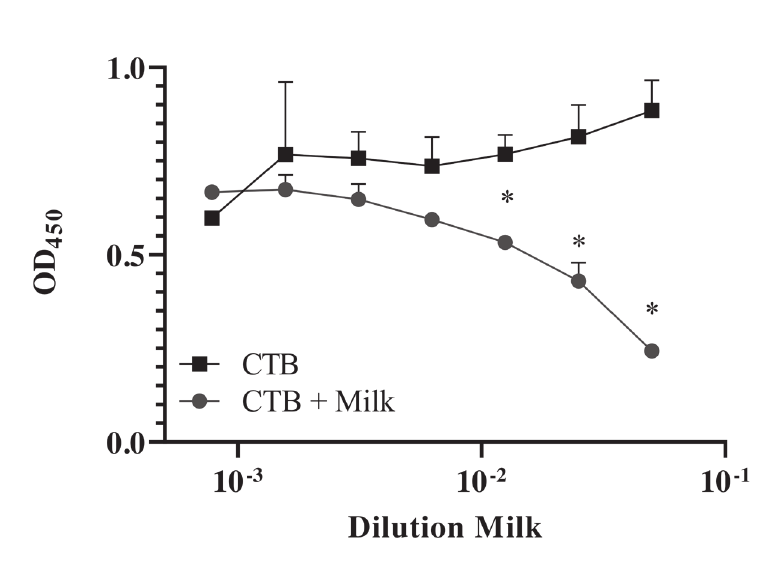
Supplementary Figure 9. Mouse Milk Competes with CT-B subunit for Binding GM-1.